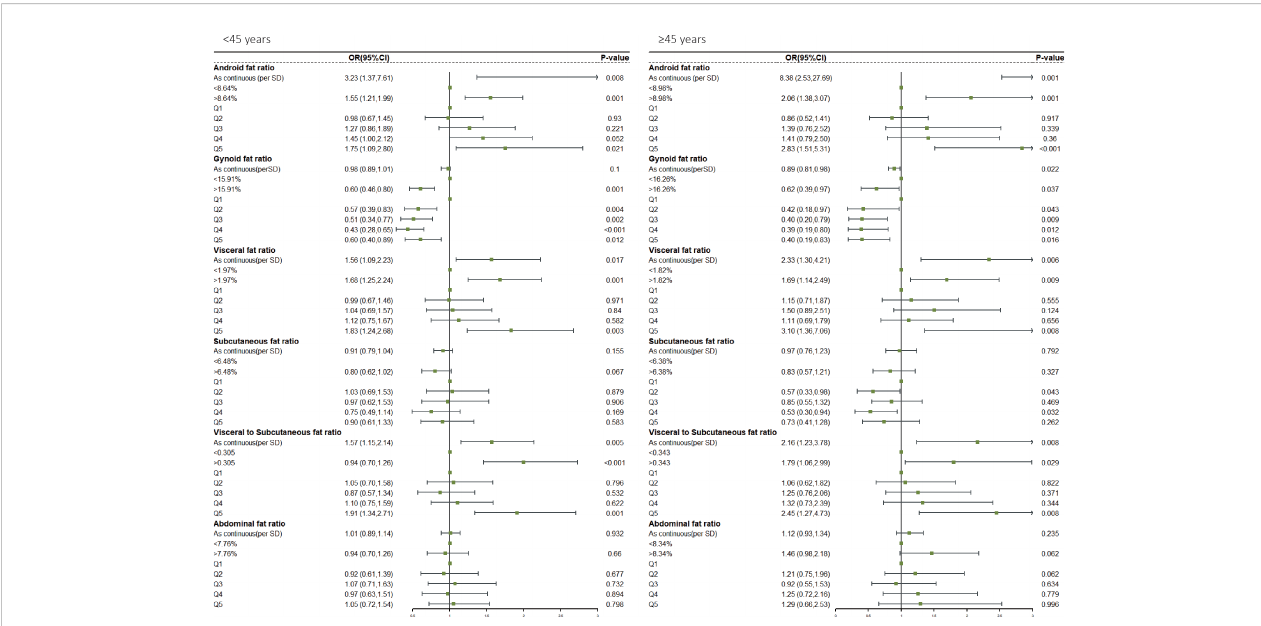
FIGURE 2 Comorbidity risk odds ratio (95% CI) of different fat distribution in obese